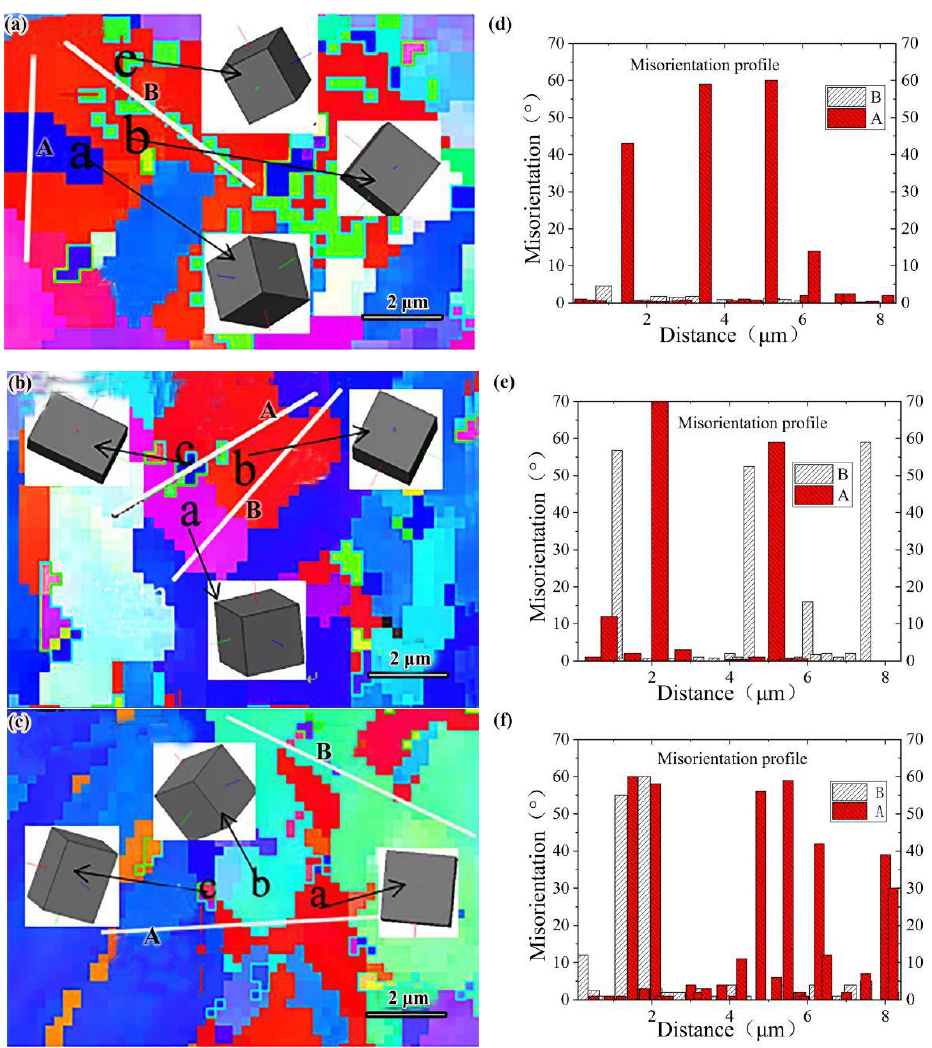
Figure 6. Grain misorientation and grain orientation stereogram: ( a – c ) represent the magnified view of grain boundary orientation of as-deposited, QT and SR specimens; ( d – f ) represent the grain misorientation of the as-deposited, QT and SR specimens.